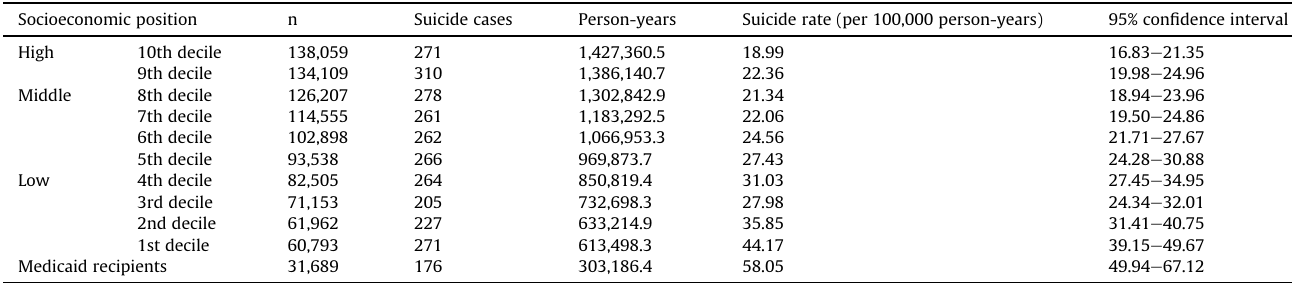
Table 2 Suicide rates across socioeconomic position groups. Socioeconomic position